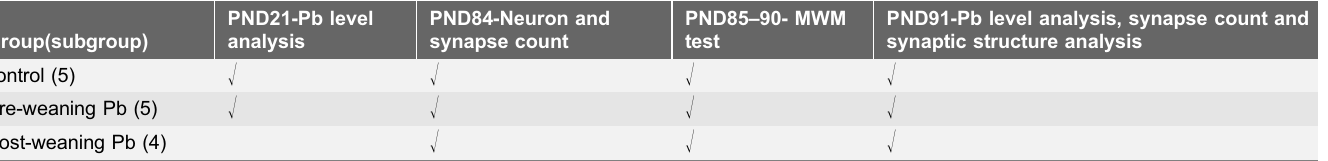
Table 1. The experimental assessment